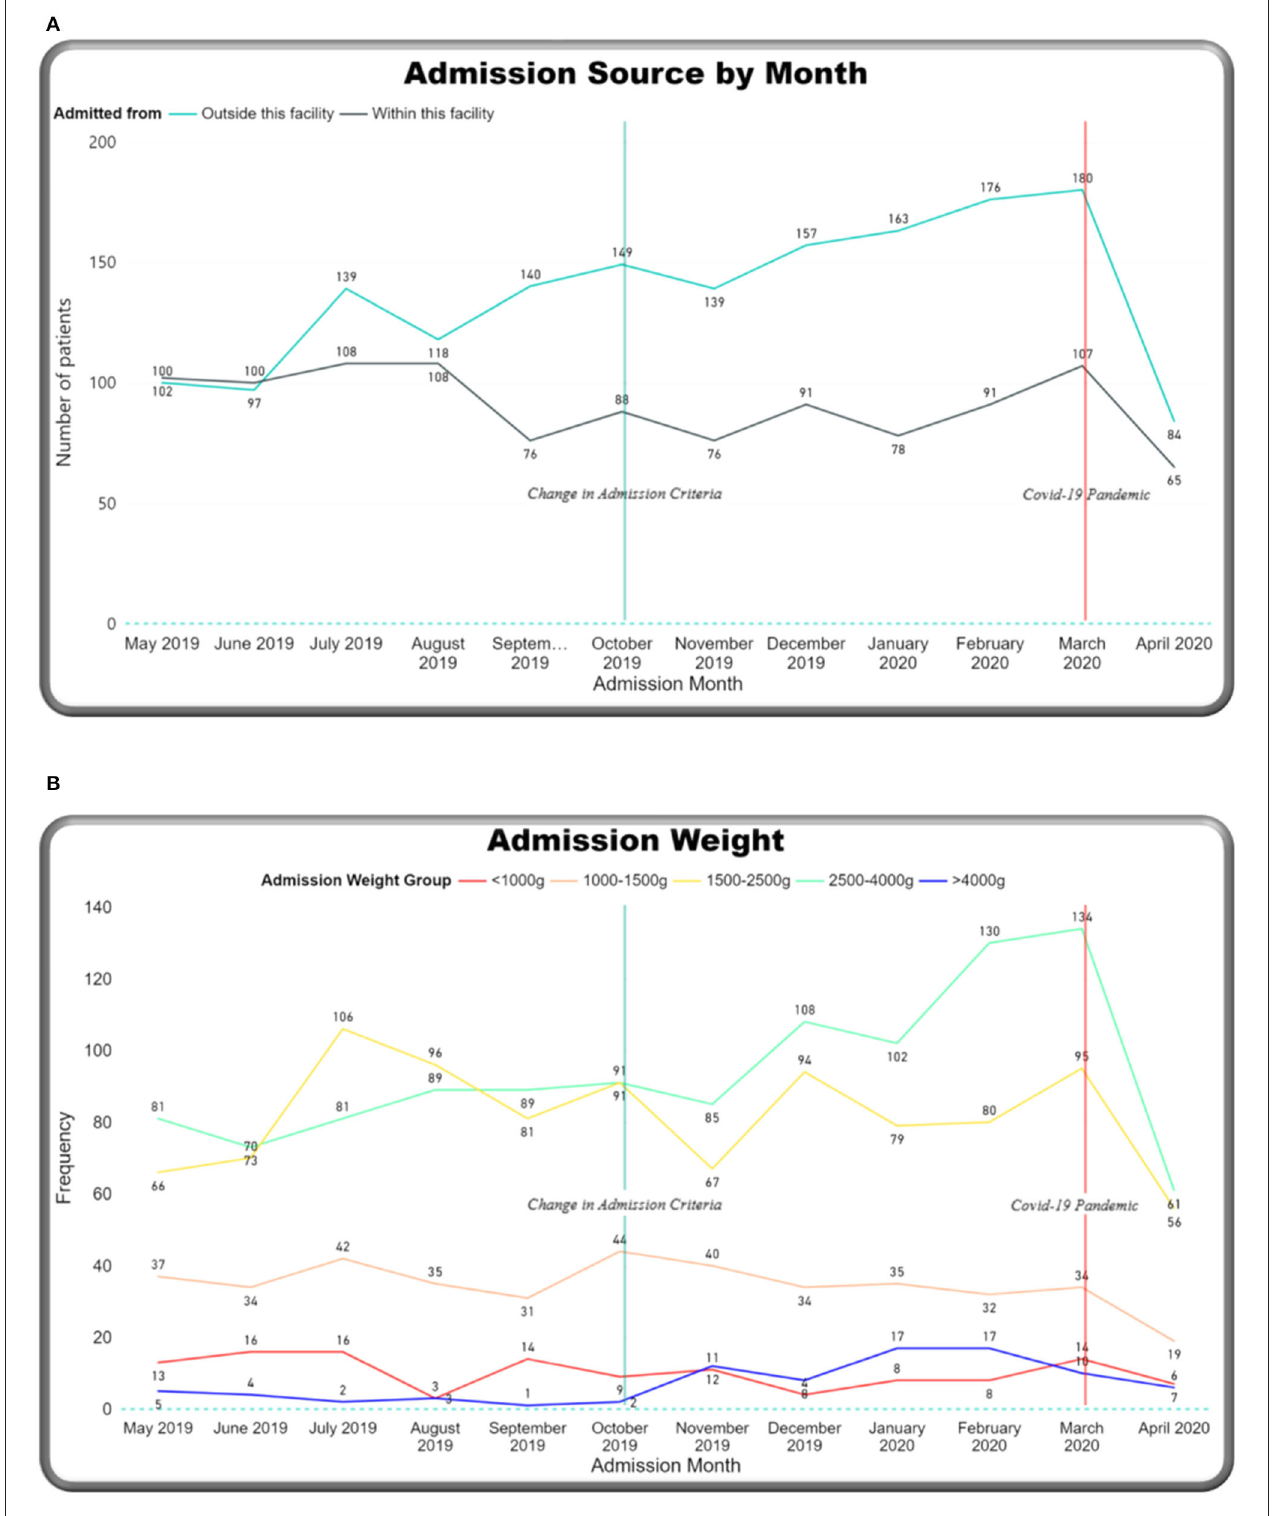
FIGURE 9 | M&M dashboard monthly trends: (A) Admission source, (B) admission weight.